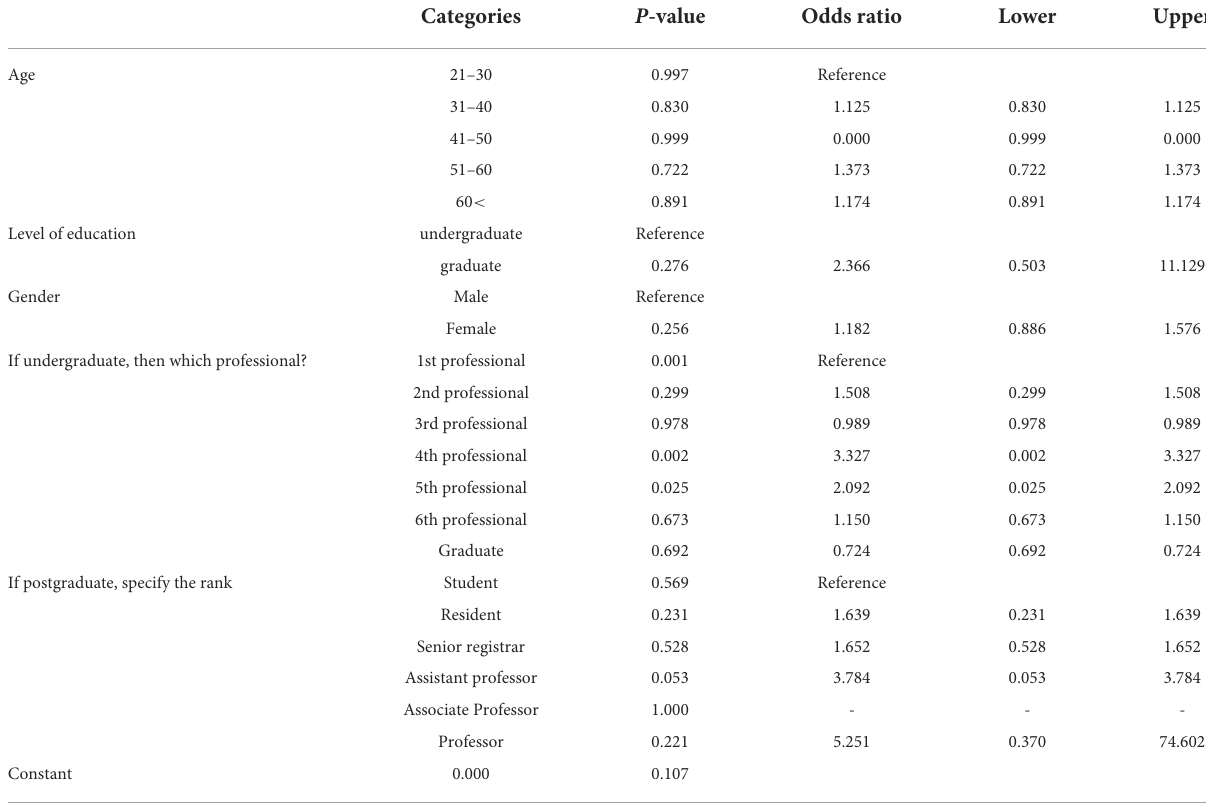
TABLE 5 Binary logistic regression between baseline characteristics of the study population and the knowledge of artificial intelligence *